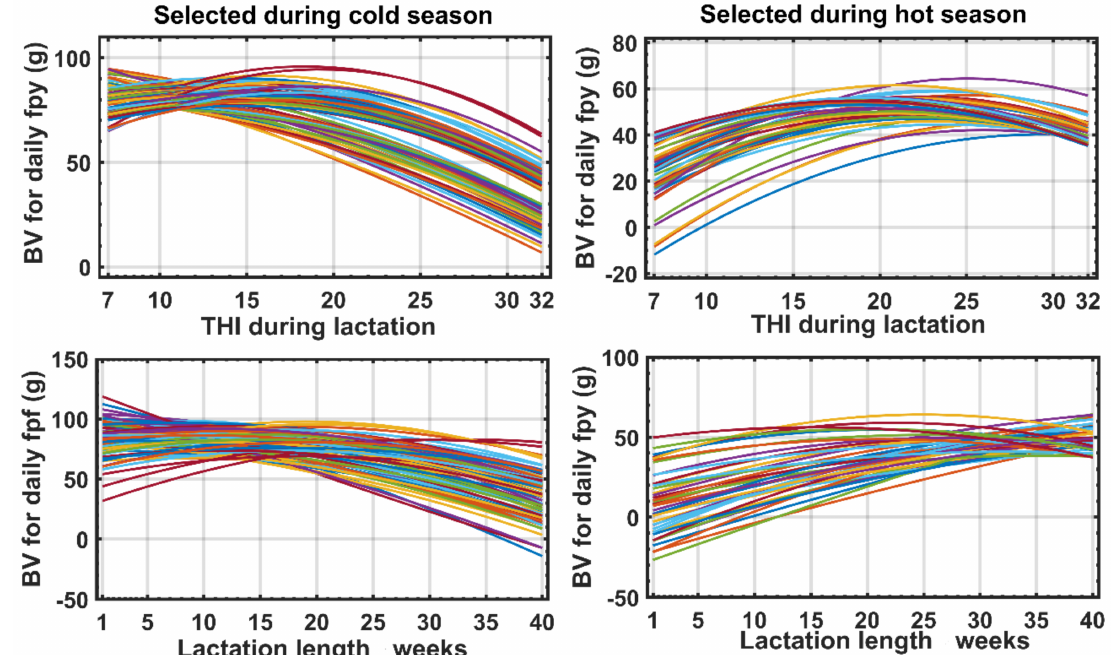
Figure 5. Variation in the form of response of the Breeding Values (BV) throughout the weeks of lactation and THI levels for daily fat and protein yield (g) estimated from the best 500 animals in the Florida breed.